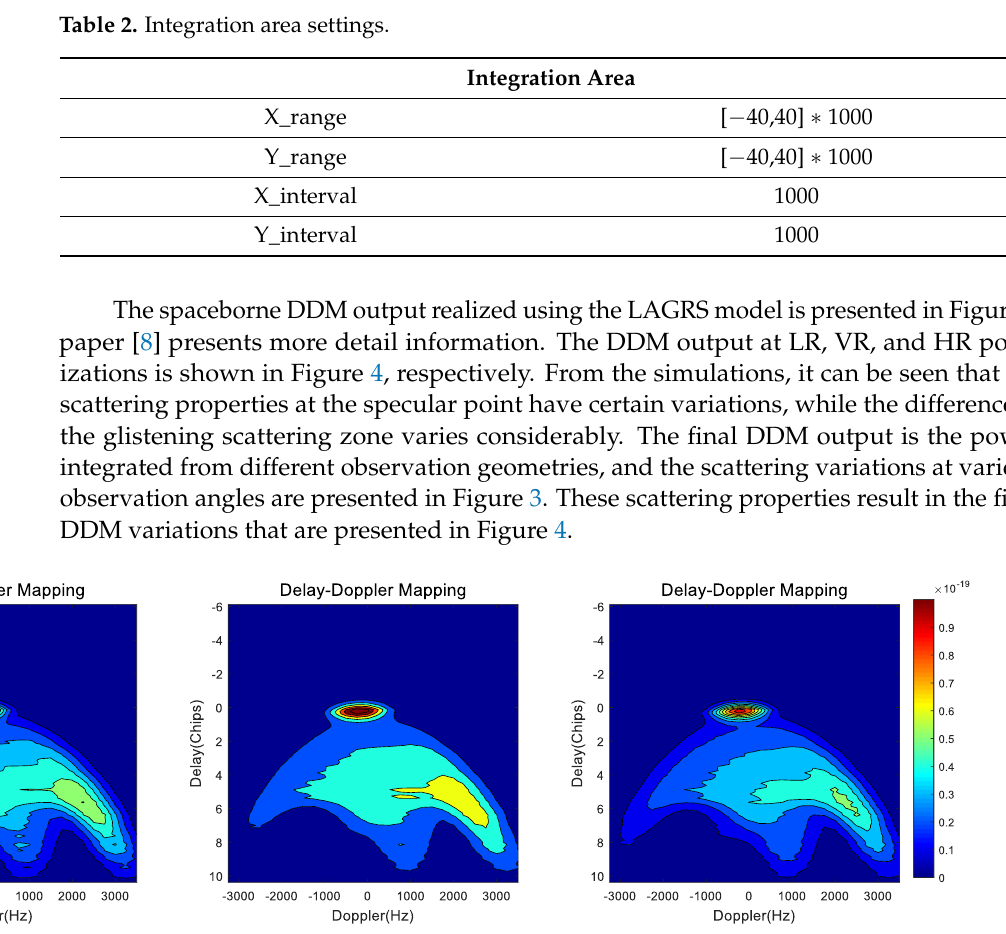
Figure 4. DDM variations at LR ( left ), VR ( middle ), and HR ( right ) polarizations.